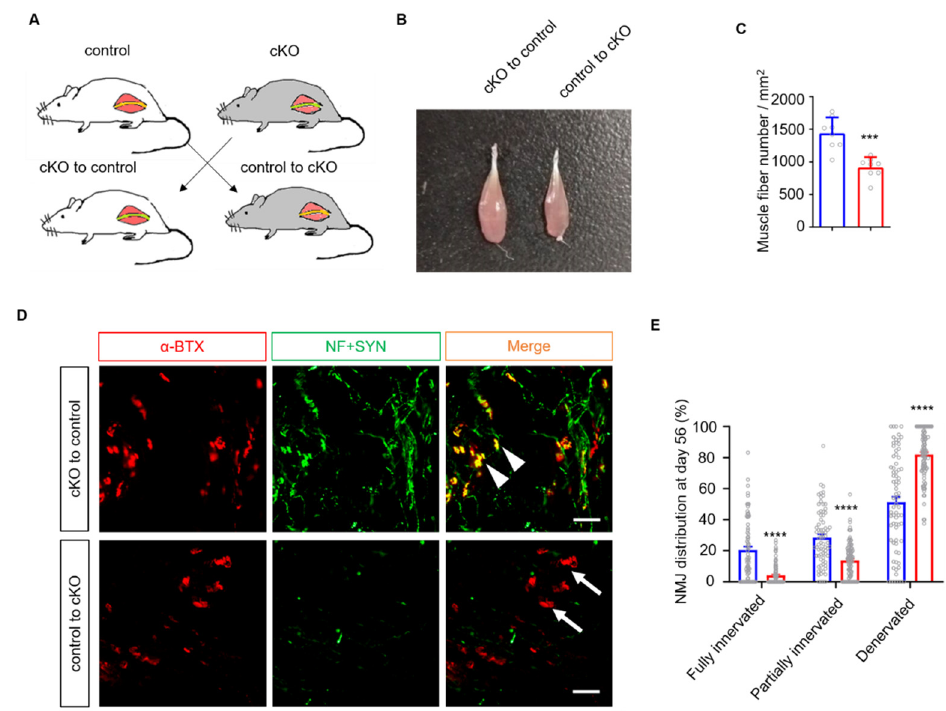
Figure 3. mSCs are involved in accelerating regeneration in Lrp4 cKO mice. ( A ) Schematic representation of the nerve exchange experiment. ( B ) The TA muscles in the cKO mice exhibited amyotrophy at 56 days after the transplant surgery. ( C ) Decreased TA muscle fiber numbers in control mice (1437.0 ± 86.9) compared with cKO mice (916.4 ± 55.9). Control and cKO, n = 8 slices, 3 mice/group, *** p = 0.0002. ( D ) Representative images of NMJ regeneration at 56 days after nerve transplant. The arrowheads indicate fully reinnervated NMJs. The arrows indicate denervated NMJs. Scale bar = 100 µ m. ( E ) Reduced fully reinnervated and increased denervated endplates in cKO after nerve transplantation. **** p < 0.0001, control, n = 75 slices; cKO, n = 93 slices, 6 mice/group. The fully innervated NMJ percentage was 20.3 ± 2.3% in the control mice, compared with 4.2 ± 0.7% in the cKO mice; the partially innervated NMJ percentage was 28.5 ± 2.1% in the control mice, compared with 13.7 ± 1.2% in the cKO mice; and the denervated NMJ percentage was 51.2 ± 3.6% in the control mice, compared with 82.0 ± 1.6% in the cKO mice. All the data are presented as the mean ± SEM.